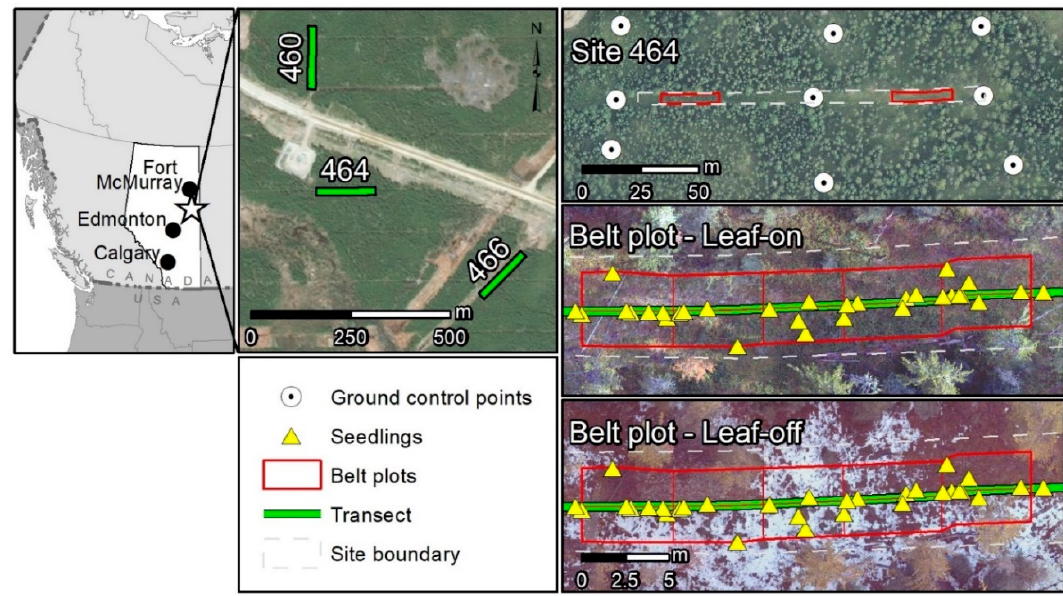
Figure 1. Left: study area location in Alberta, Canada. Center: Close-up of the study area showing the three sites. Upper right: site layout. Middle right: example of drone-based image point cloud (DIPC) orthomosaic of a belt plot in leaf-on conditions. Lower right: Same in leaf-off conditions. NB. The transect line divides the belt plot in two halves, hence there are ten sub-plots, five at each side.